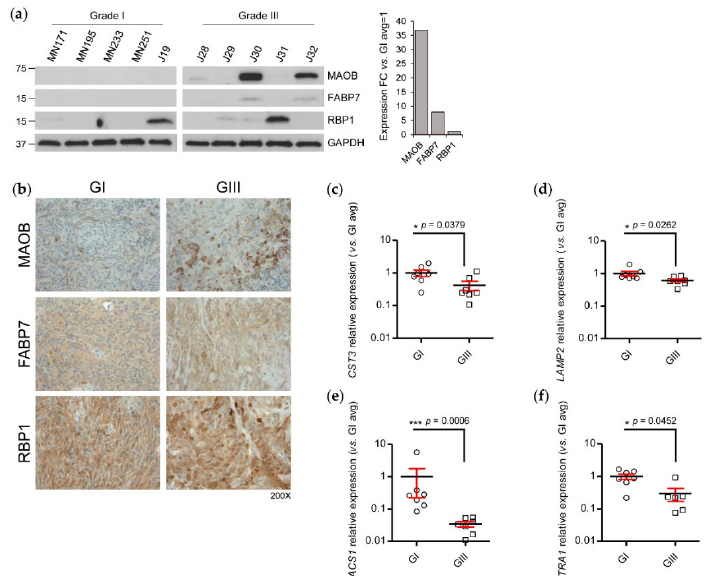
Figure 5. The druggable grade III meningioma proteome. ( a ) Proteins with increased concordant expression in grade III vs. grade I meningiomas also associated with Food and Drug Administration (FDA)-approved drugs are displayed. ( b ) Top 20 concordantly expressed proteins based on average rank value and their associated FDA-approved drugs following submission to the drug–gene interaction database (DGIdb, v3.0). Table S6 provides details of transcripts/proteins associated with FDA-approved drugs.